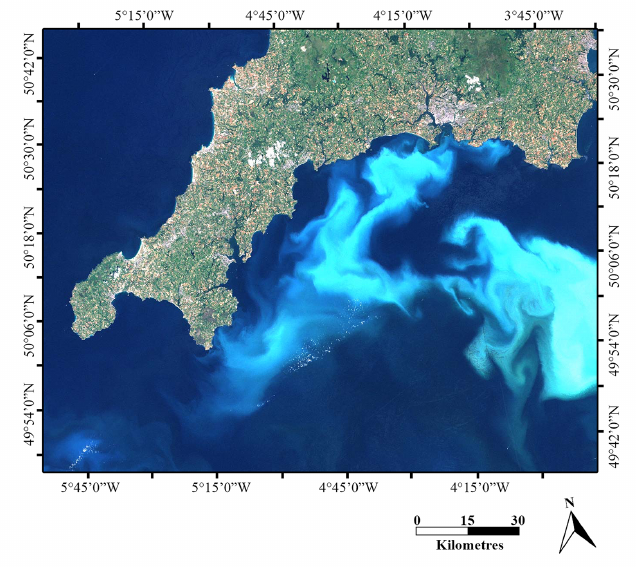
Figure 1. Satellite image of an algal bloom off the southwest coast of England. This Landsat 7 false colour image was taken on 24 July 1999 and shows the spread of phytoplankton E. huxleyi , a species of coccolithophore. Image provided by the NERC EO Data Acquisition and Analysis Service Plymouth, with permission from S. Groom [37]. Approximate scale, north arrow and